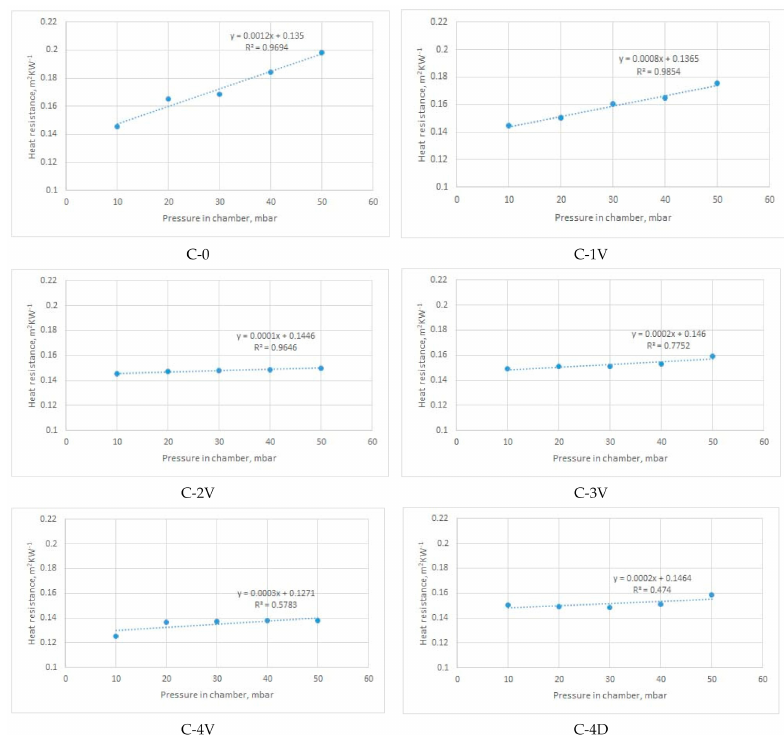
Figure 13. Dependence of heat resistance and air pressure of inflated PICs at a constant ambient temperature of 15 ◦